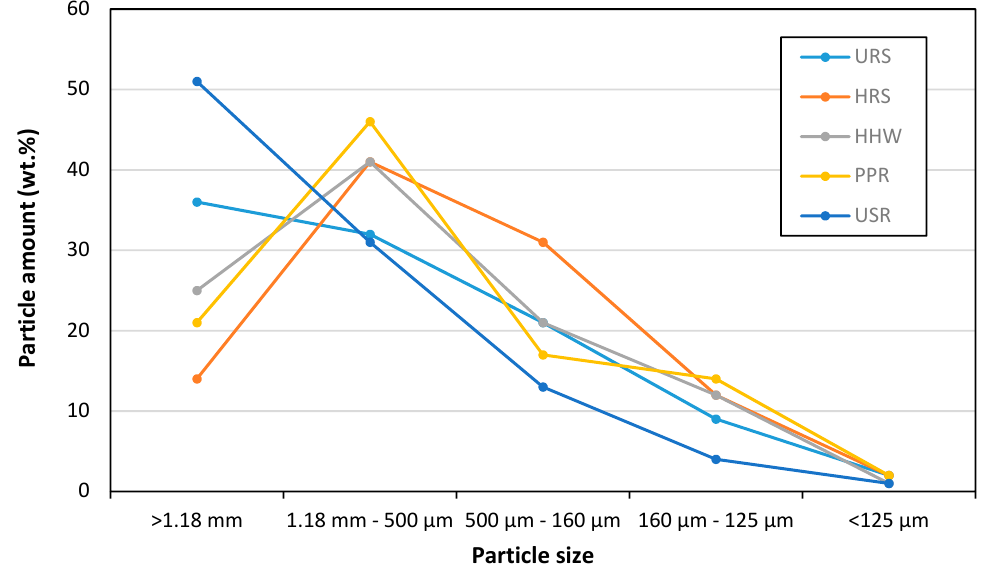
Figure 3. The particle size distribution of feedstocks for pellet production.